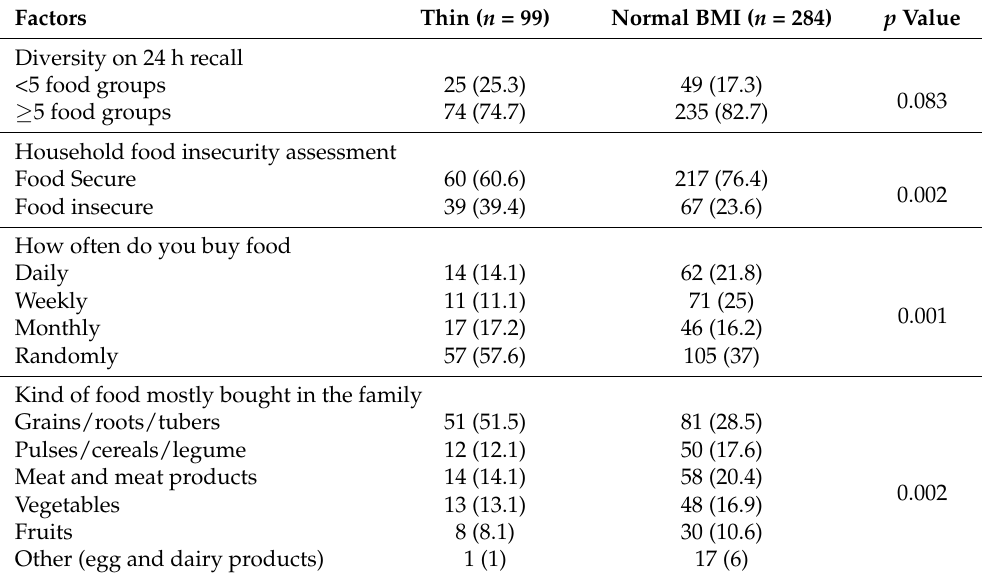
Table 3. Dietary intake, food availability and food-related practice factors for thin and normal BMI